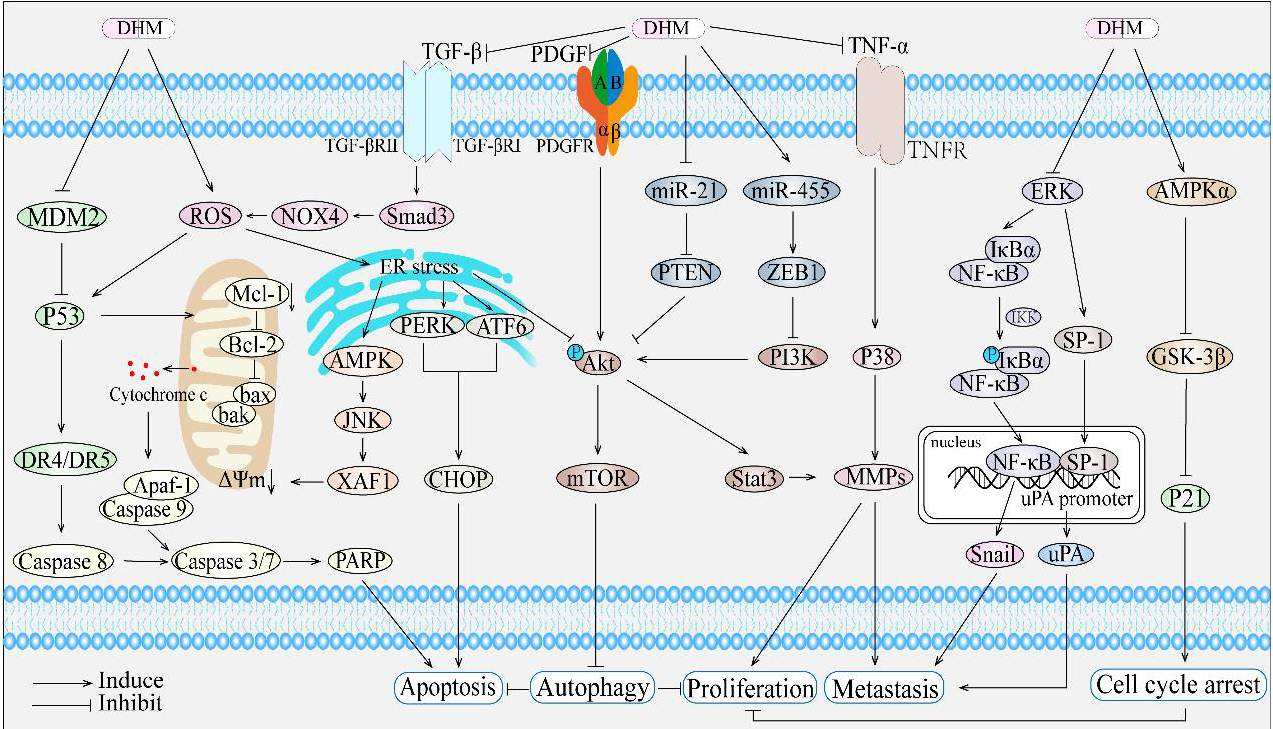
Figure 1. Anticancer mechanisms of dihydromyricetin. DHM regulates MDM2-mediated p53 pathway to trigger apoptosis in exogenous death receptor pathway and inhibits TGF-β-Smad3 signaling, disturbs ROS balance, and promotes apoptosis in endogenous mitochondrial and endoplasmic reticulum pathways. DHM also induces autophagy through the PDGFR/Akt/mTOR pathway, inhibiting cell proliferation. In addition, DHM inhibits miR-21/PTEN/Akt pathway, miR-455/ZEB1/PI3K pathway, TNF-α/P38/MMP pathway, and ERK/NF-κB/Snail pathway, as well as ERK/SP-1/uPA pathway, thereby suppressing cancer cell metastasis and proliferation. Furthermore, DHM can also activate AMPK α/GSK-3β/P21 pathway, leading to cell cycle arrest.